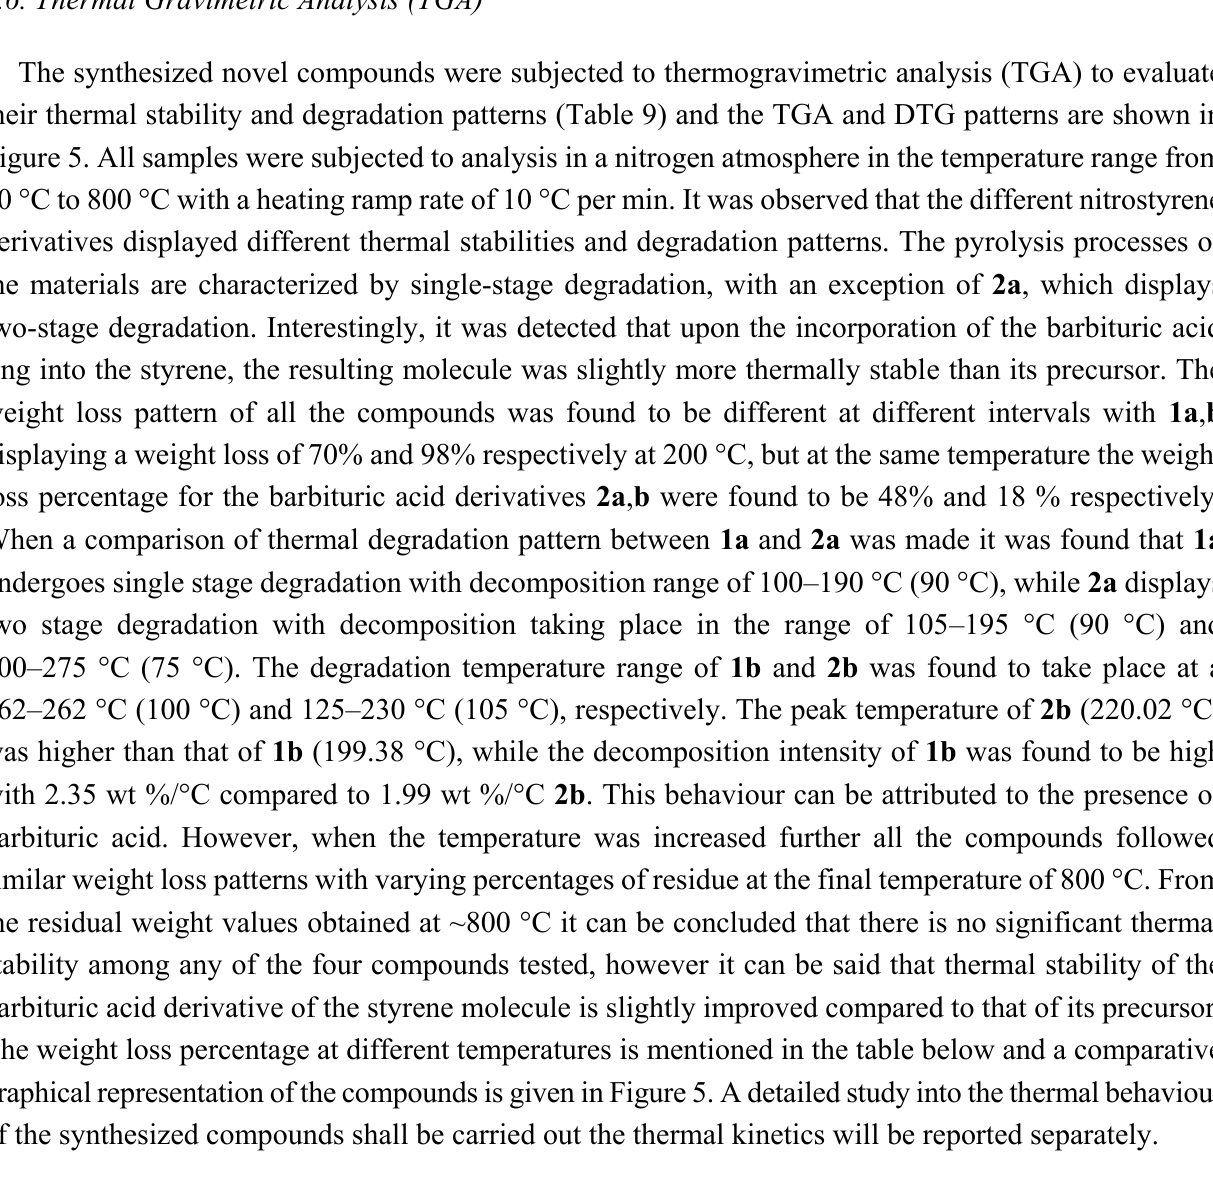
Table 9. Weight loss percentage at different temperatures for 1a , b and 2a , b